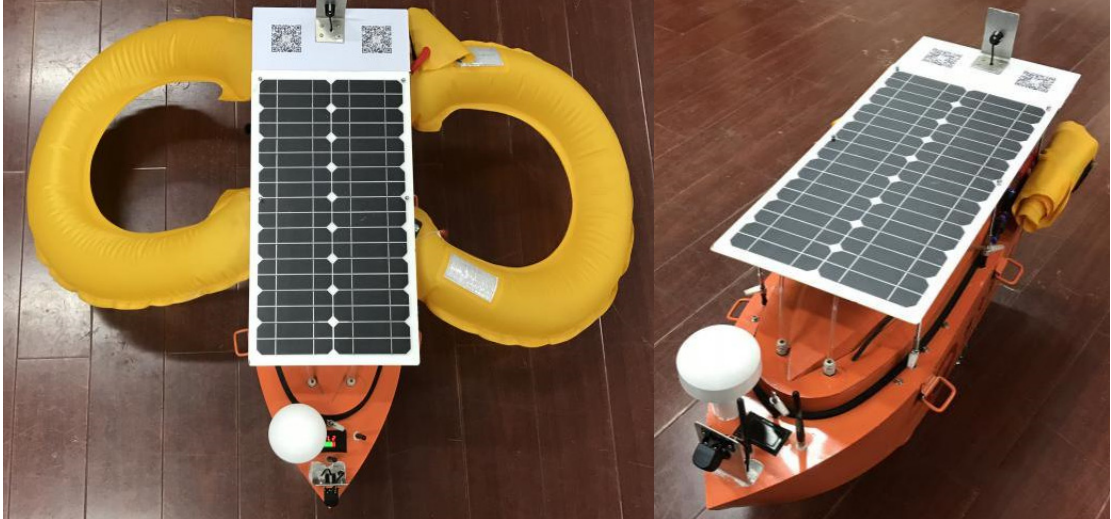
Figure 1. Main functions and structure of the unmanned ship.